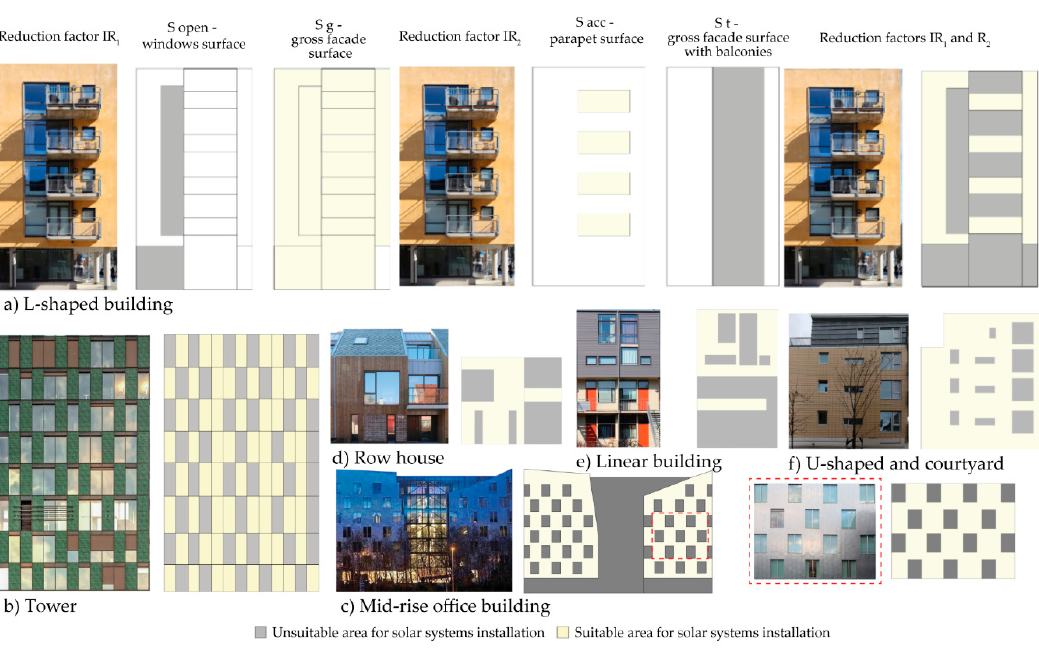
Figure 7. Examples of graphical calculation of the reduction factors IR 1 and IR 2 for the L-shaped building and a summary of the calculation of the factors for all of the building morphologies.